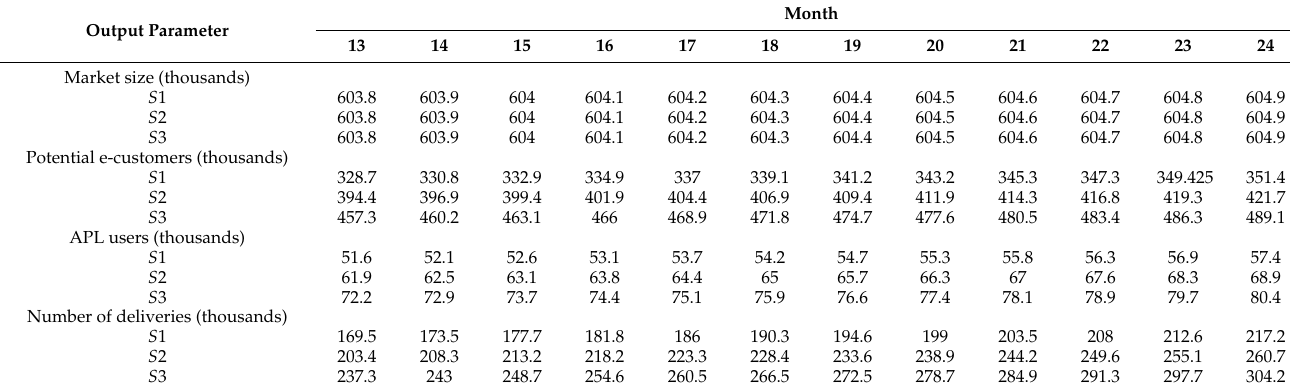
Table A2. Results generated by the SDSM in the second year.